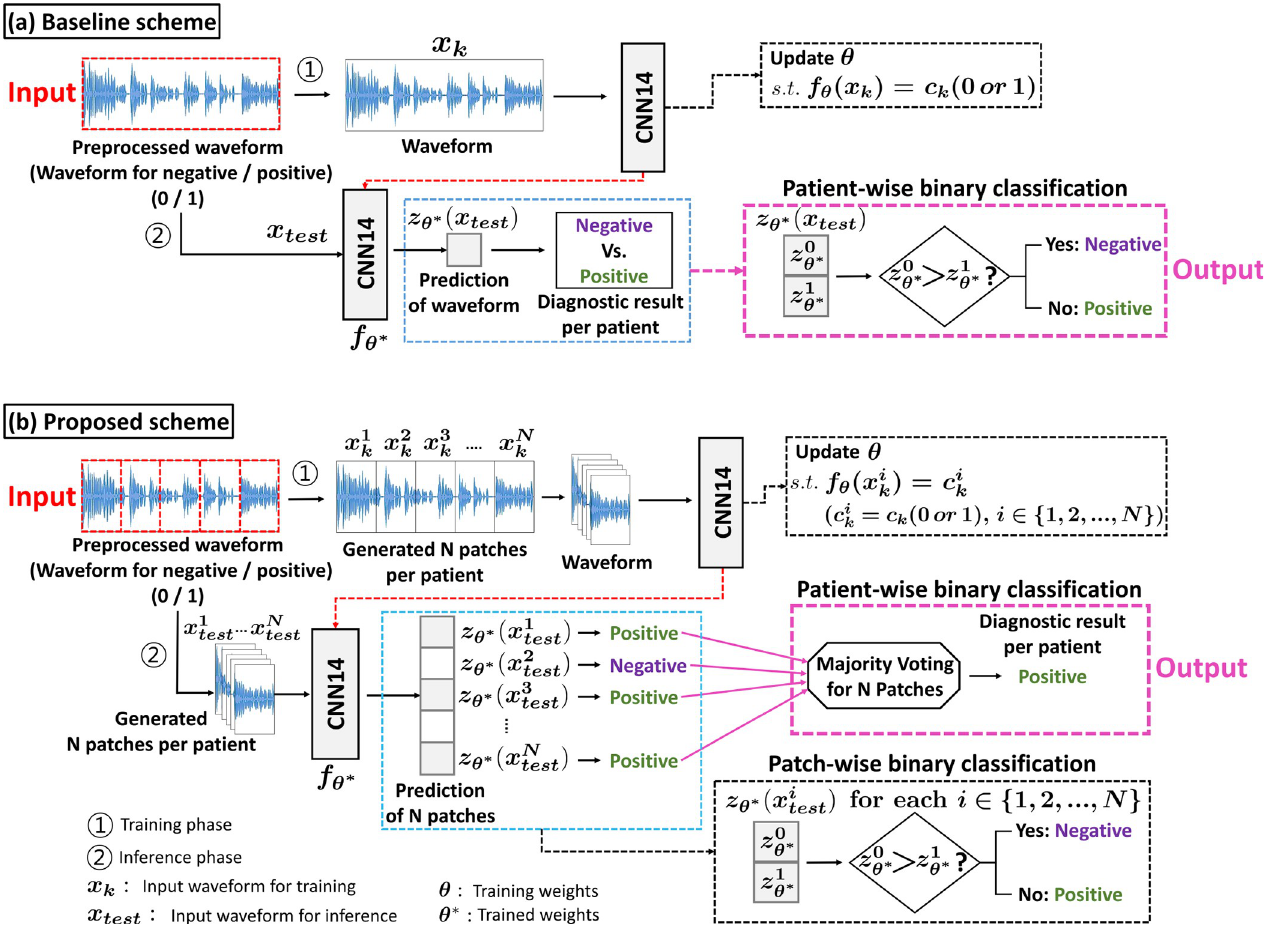
Fig 2. Overview of the proposed PWSI-AI-AC. (a) Baseline scheme: The network receives the entire waveform as an input and performs learning and inference for the binary classification. (b) Proposed scheme: Unlike the baseline method, the entire waveform is divided into N patches, and the network receives the individual patch waveform as input and learns to perform binary classification for each patch. In the inference phase, N results are synthesized through majority voting to obtain the final binary classification result for the target patient. Through this diversity gain, performance improvement can be